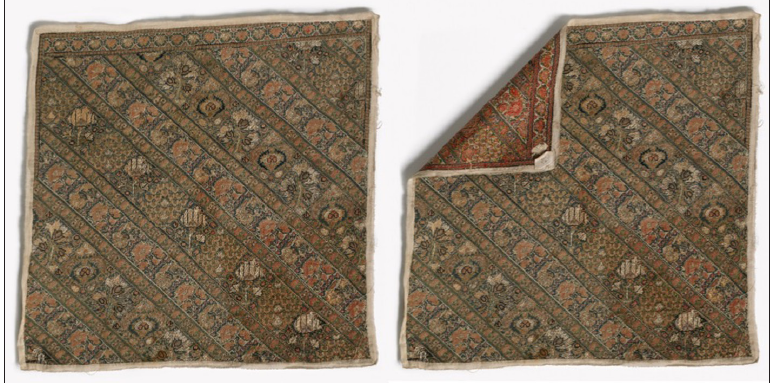
Fig. 12 : Trouser panel, silk and cotton, Iran, nineteenth century. T24, given by Miss E. G. Tanner in 1928. © Holburne Museum, Bath. Photo: